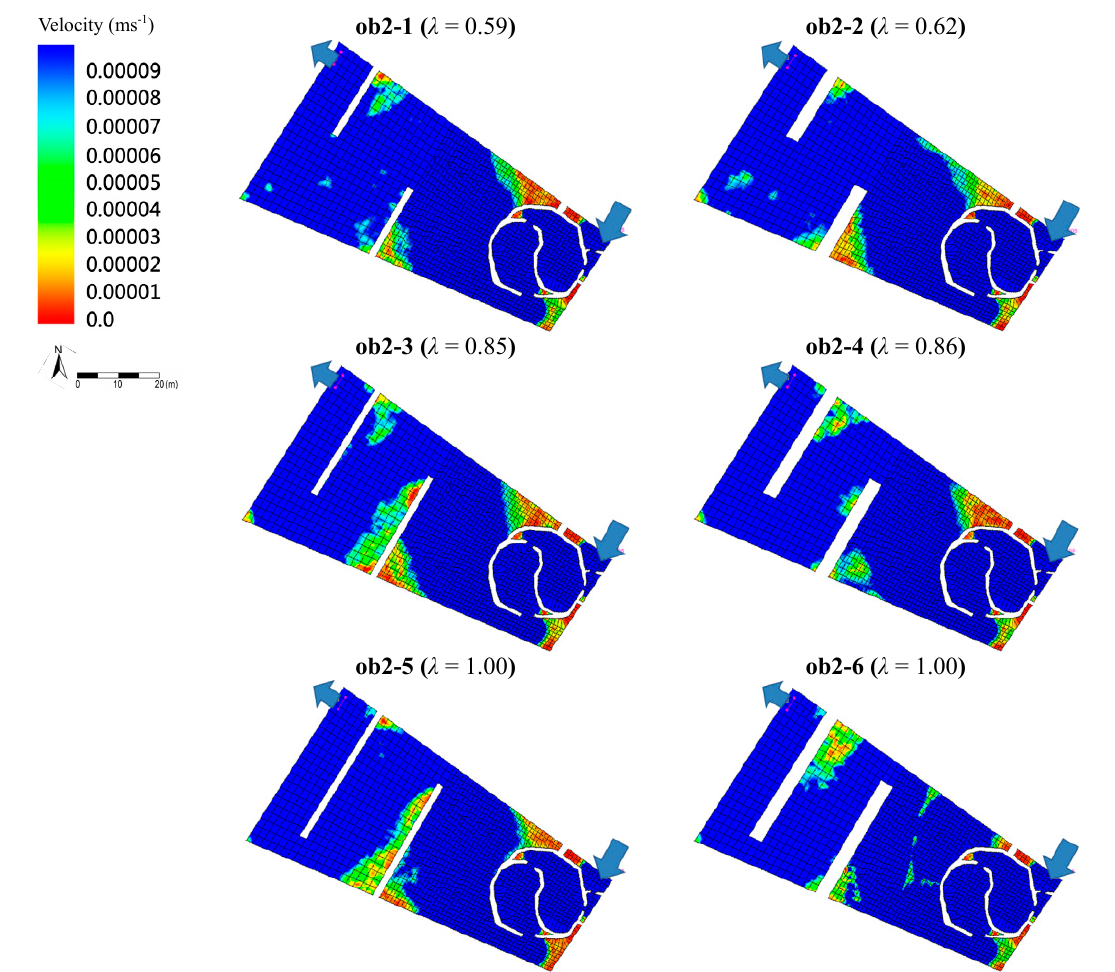
Figure 8. Spatial distribution of the flow velocity in the pond after installing two baffles in different locations with different dimensions. The blue arrows indicate the flow inlet and outlet, whereas the white rectangular bars represent the baffles. The hydraulic efficiency is shown in parentheses according to the name of each scenario.